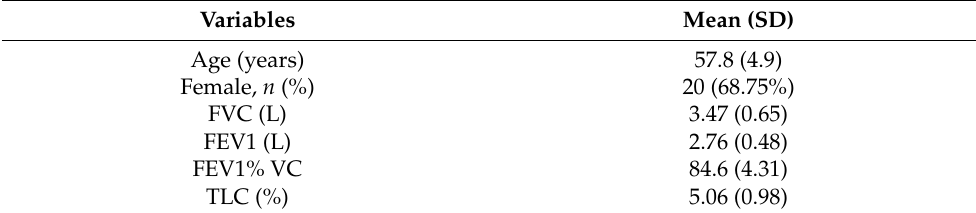
Table 1. Group characteristics.